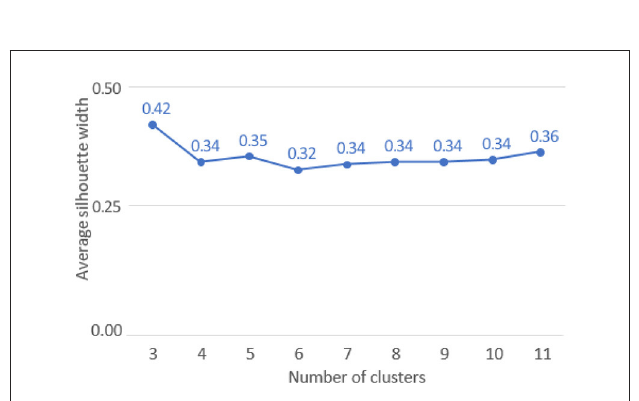
FIGURE5 Average Silhouette Width for each set of clusters ( K =